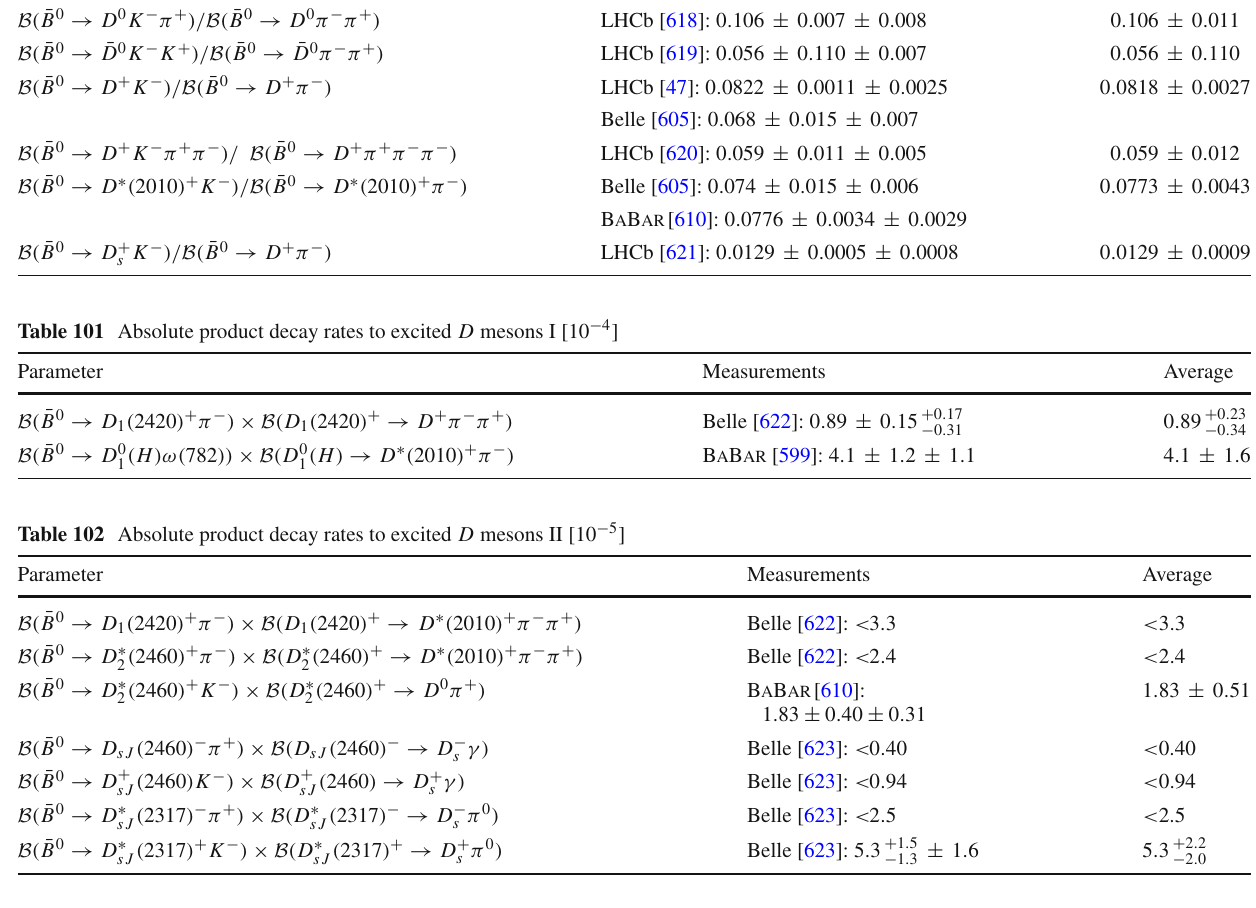
Table 103 Absolute and relative decay rates to excited D mesons [ 10 − 2 ]